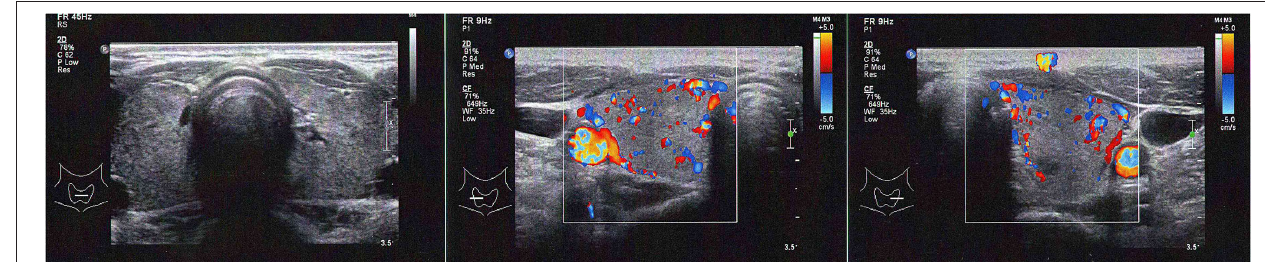
FIGURE 1 | Technetium thyroid scan at the diagnosis of Graves’ disease of our patient.